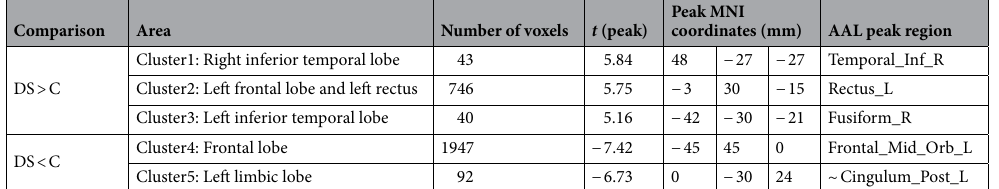
Table 3. Significant between-group differences in ReHo maps. C: Controls ; MNI: Montreal Neurological Institute.; ~ : approximately, AAL atlas area closer to the t peak.